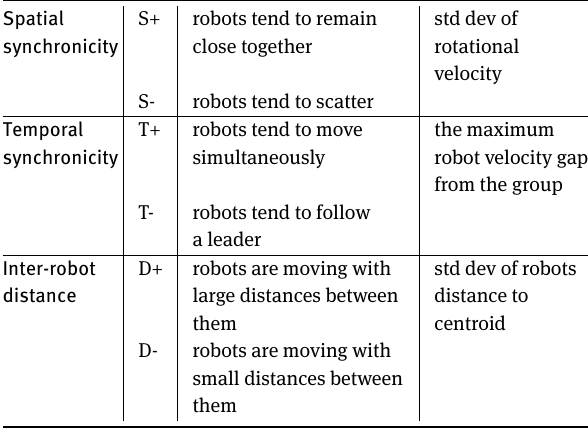
Table 2: The six experimental